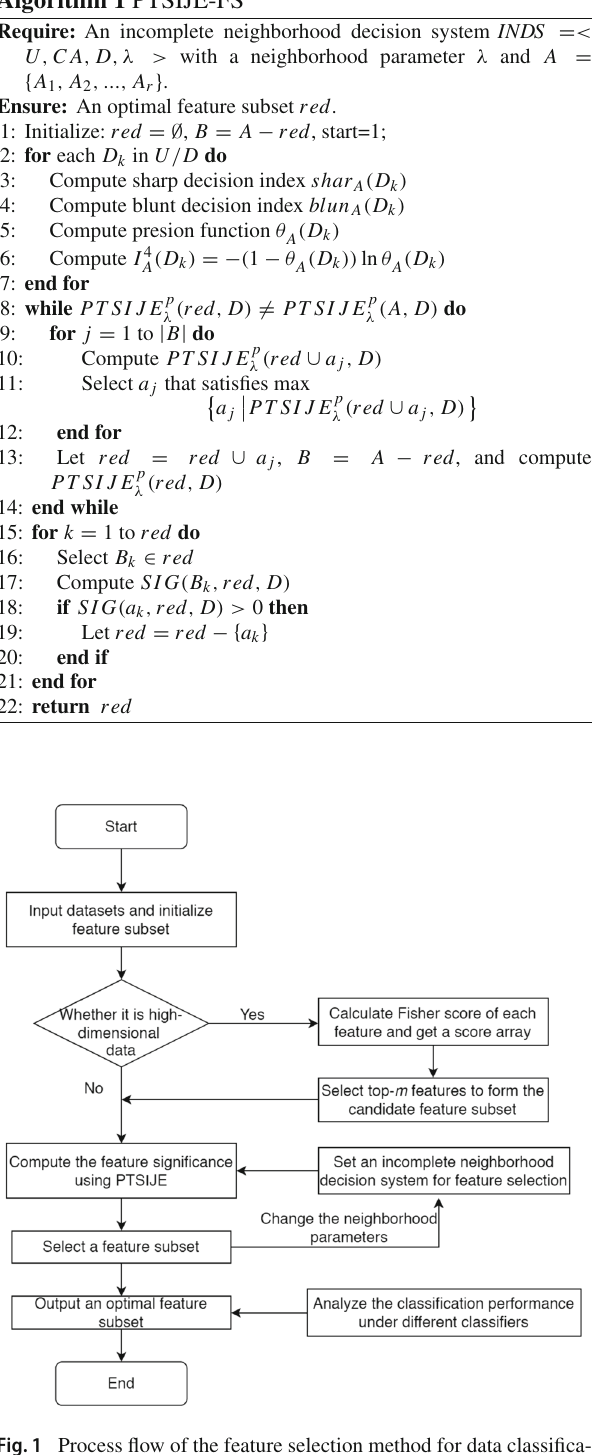
(2) For any A i ⊆ A (cid:15) , PT SI J E p λ ( A (cid:15) , D )< PT SI J E A i , D )